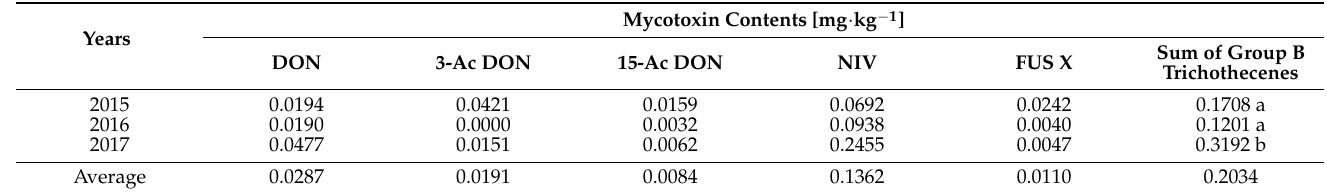
Table 7. Content of type B trichothecenes (deoxynivalenol—DON, 3-ACDON, 15-AcDON,